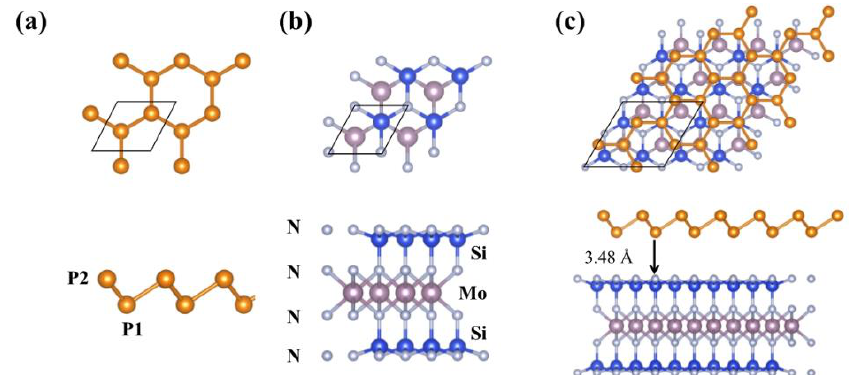
Figure 1. Top and side views of the crystal structures for ( a ) Blue P ML, ( b ) MoSi 2 N 4 ML, and ( c ) Blue P/MoSi 2 N 4 vdWH with the T 1 configuration. The rhombuses in the top views represent the unit cells of these 2D materials. The element symbols refer to the corresponding atomic layers in the Blue P and MoSi 2 N 4 MLs in panels ( a , b ). Table 1. Lattice constants, binding energies, interlayer distances, and bandgaps of the Blue P/MoSi 2 N 4 bilayer with the four configurations together with the Blue P and MoSi 2 N 4 MLs. Blue P MoSi 2 N